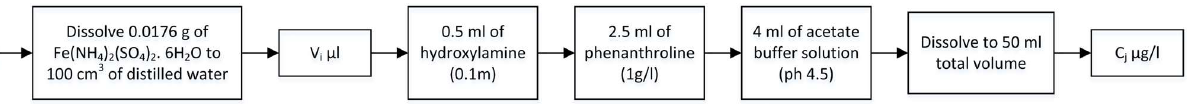
Figure 9. Flowchart for Fe 2+ standard solution preparation using phenanthroline. Vi denotes volume of iron solution necessary to prepare standard sample with concentration C j , in µg Fe 2+ /L. of iron solution necessary to prepare standard sample with concentration C